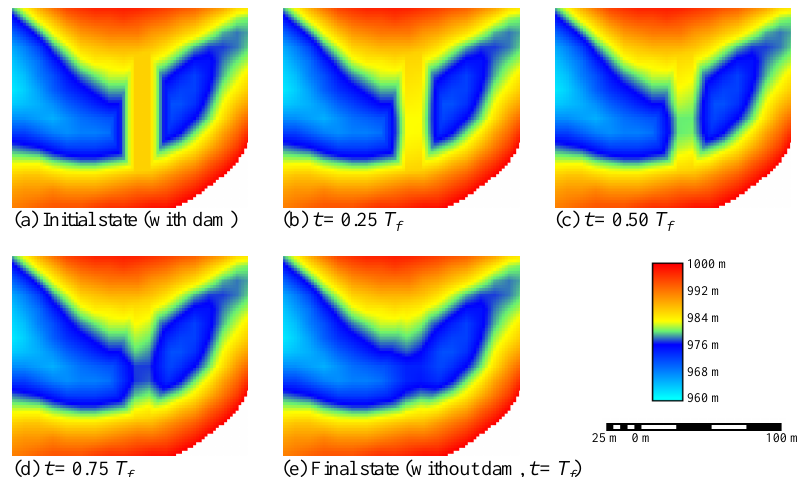
Figure 9. Plane view of the topography evolution in the near field of the landslide dam as a function of time ( T f stands for the breach formation time).